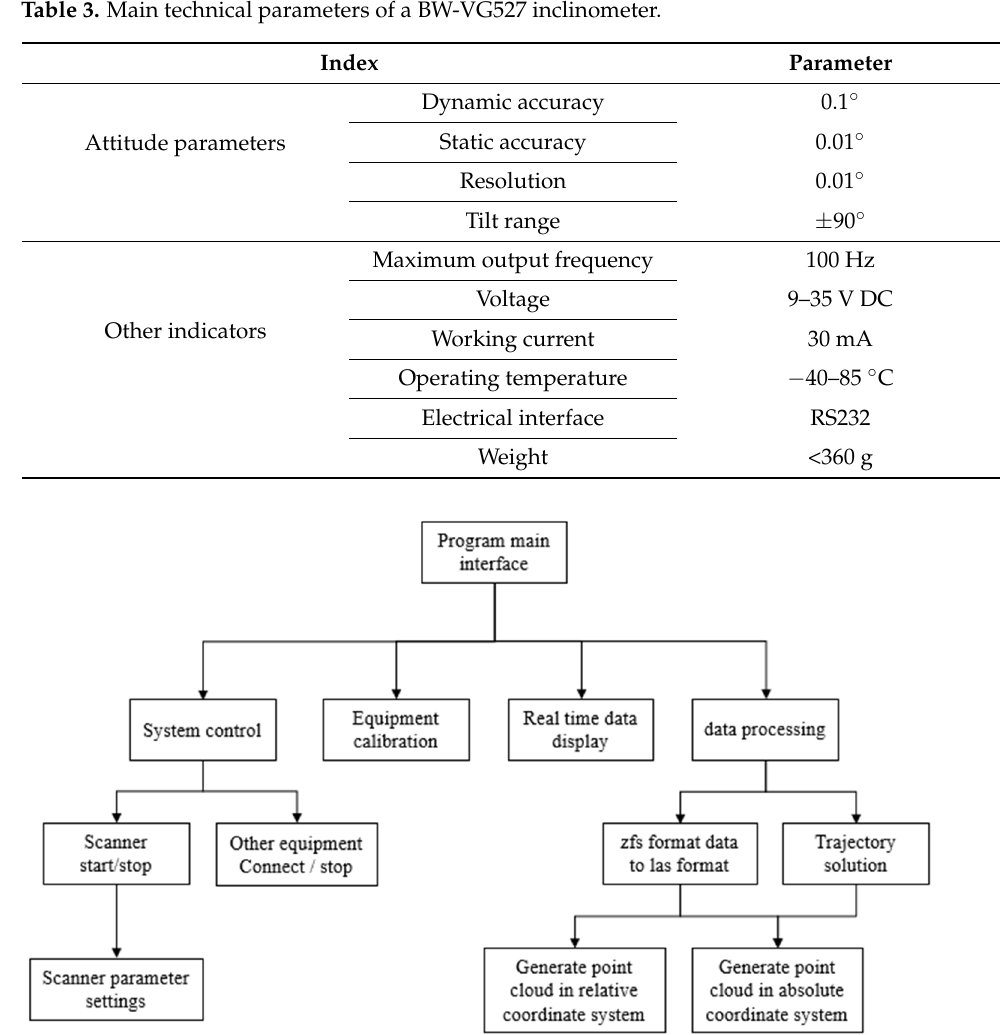
Figure 8. Program design structure diagram.